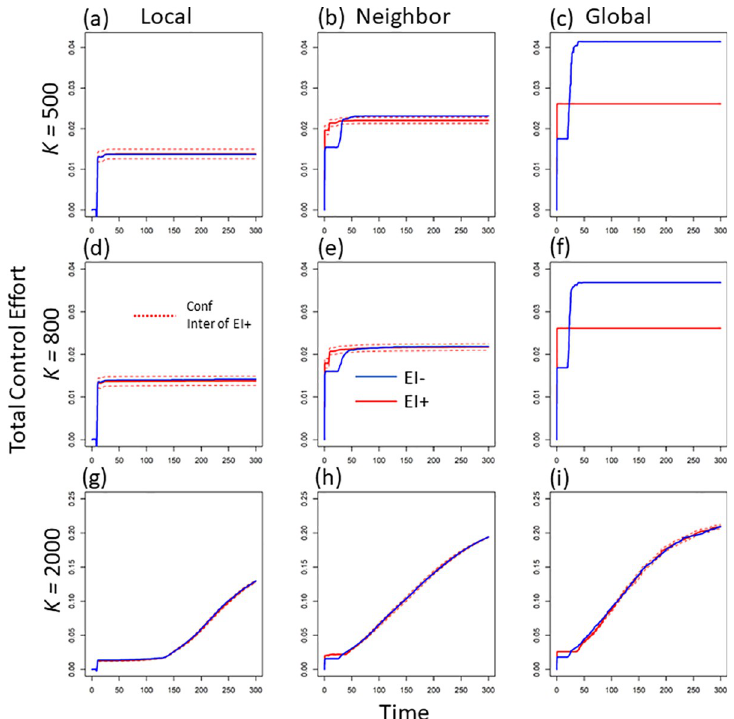
Fig 2. The dynamics of total control effort (unit: 1/time) per patch under three levels of mosquito breeding capacity (e.g., K = 500, 800 and 2000) and three scales of disease information (i.e., local, regional, and global scale). Here we exclude the patch where disease starts to get the average total control effort in one patch. The blue lines indicate the dynamic in the absence of early intervention, while the red lines are the dynamics in the presence of early intervention (the dashed red lines are the 95% confidence interval